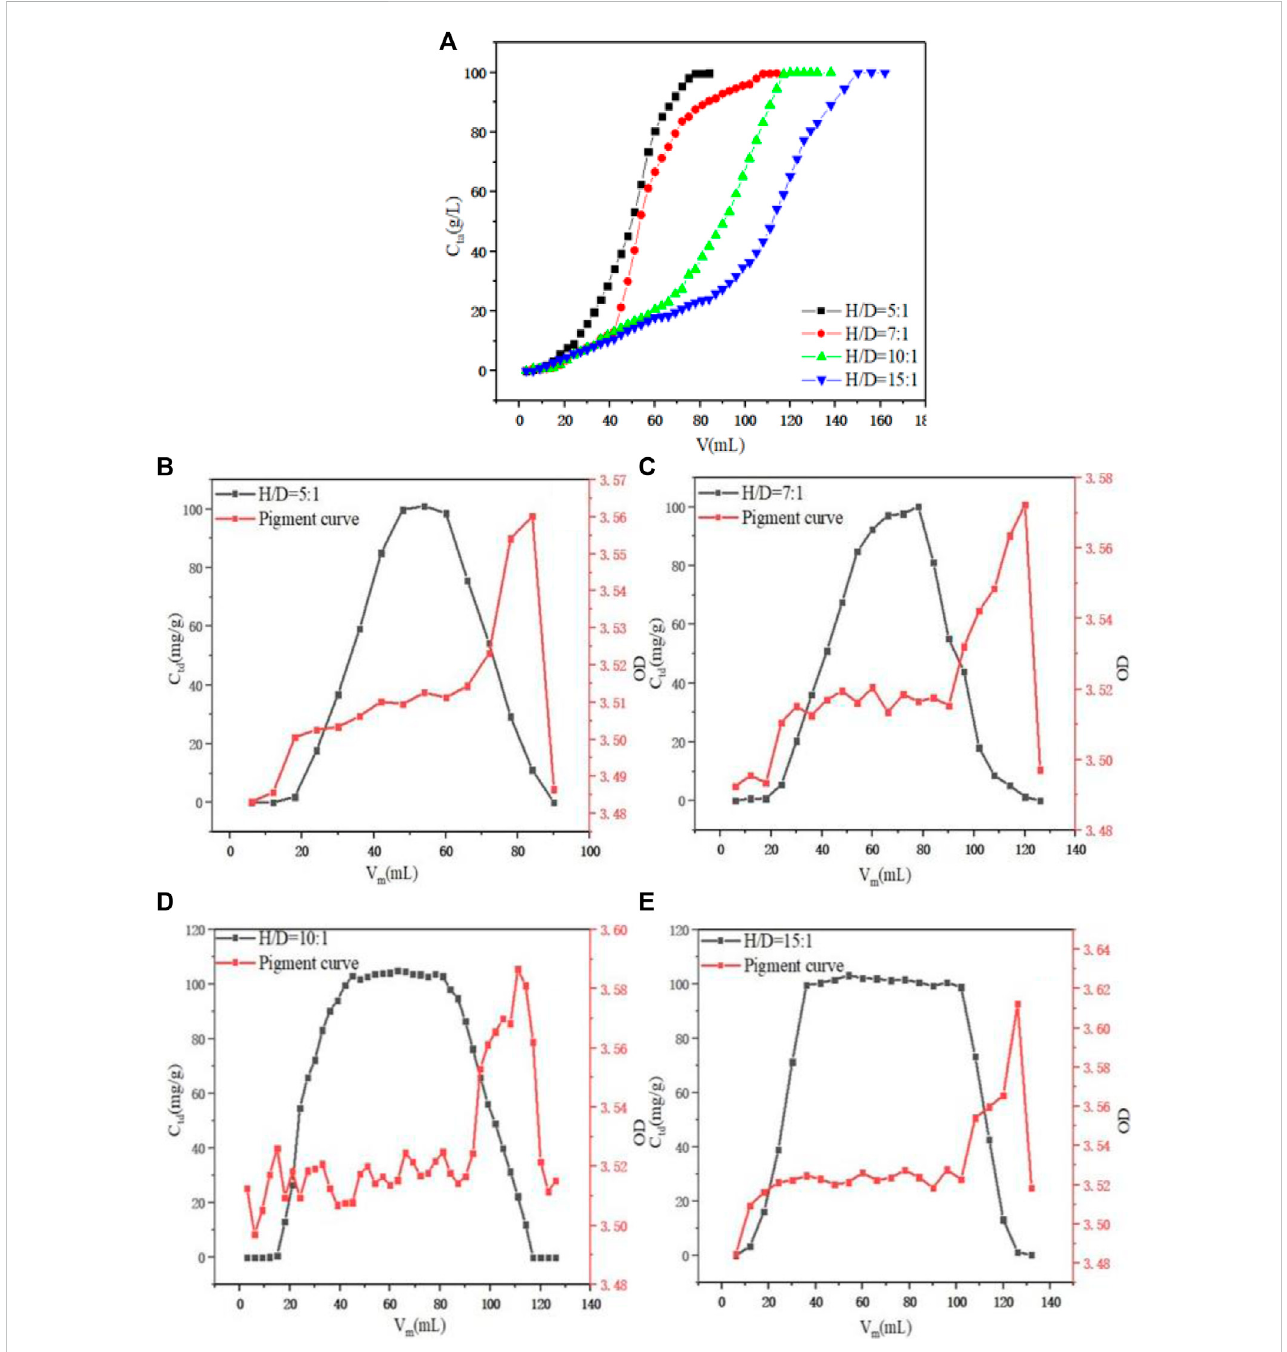
FIGURE 5 (A) EffectofH/Dondynamicadsorption. (B) EffectofH/D=5:1ondynamicdesorption. (C) EffectofH/D=7:1ondynamicdesorption. (D) EffectofH/D= 10:1 on dynamic desorption. (E) Effect of H/D = 15:1 on dynamic